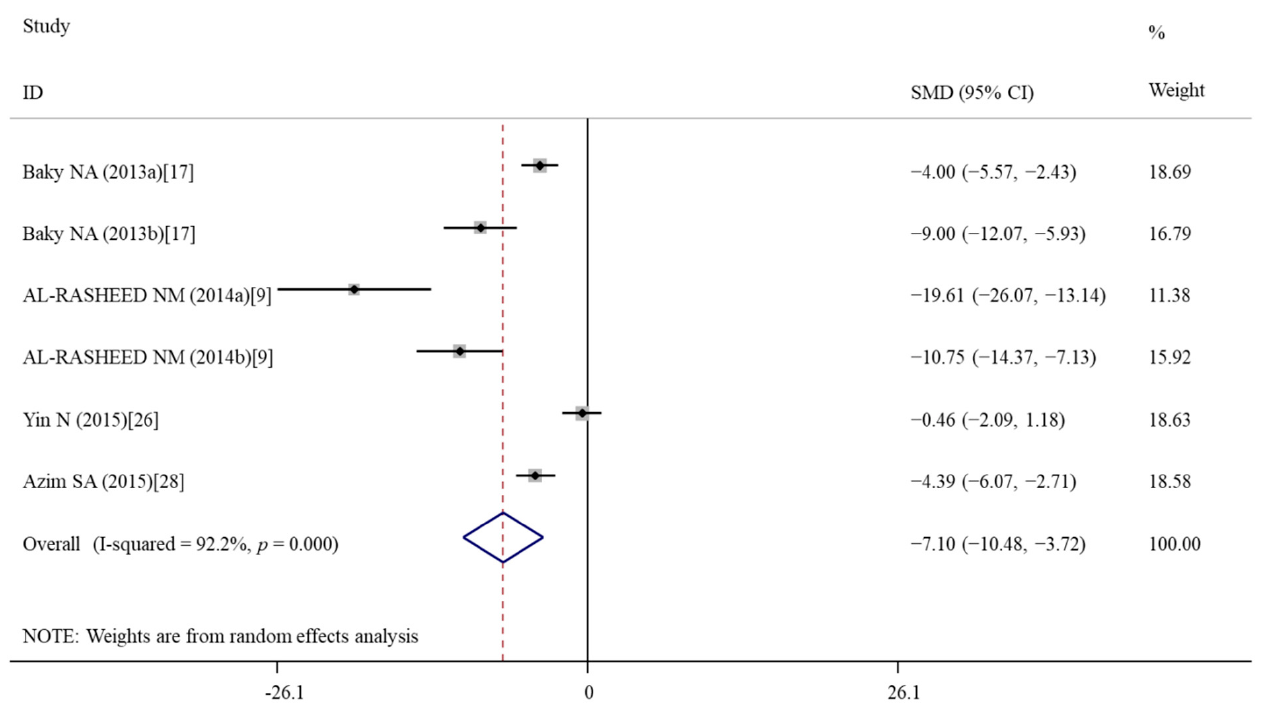
Figure 8. Forest plots showing the protective effects of vitamin E on Caspase-3 activity of murine models compared with the nanomaterial exposure group. a, b of the study of Baky et al. and AL- RASHEED et al. represent treatment with 600 and 1000 mg/kg of ZnONPs. SMD, standardized mean difference; CI, confidence interval. [9,17,26,28]